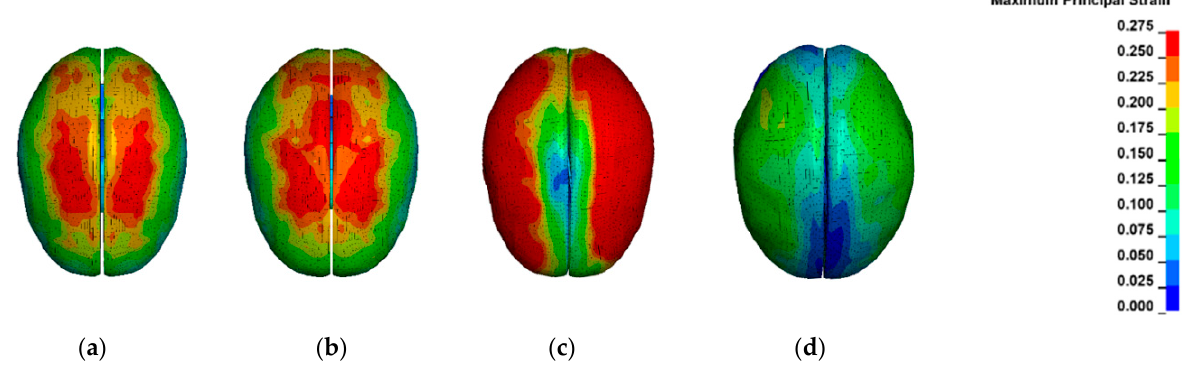
Figure 10. Maximum principal strain on the brain obtained from the inclined drop tests at ( a ) crown, ( b ) front, ( c ) rear, and ( d ) side locations.